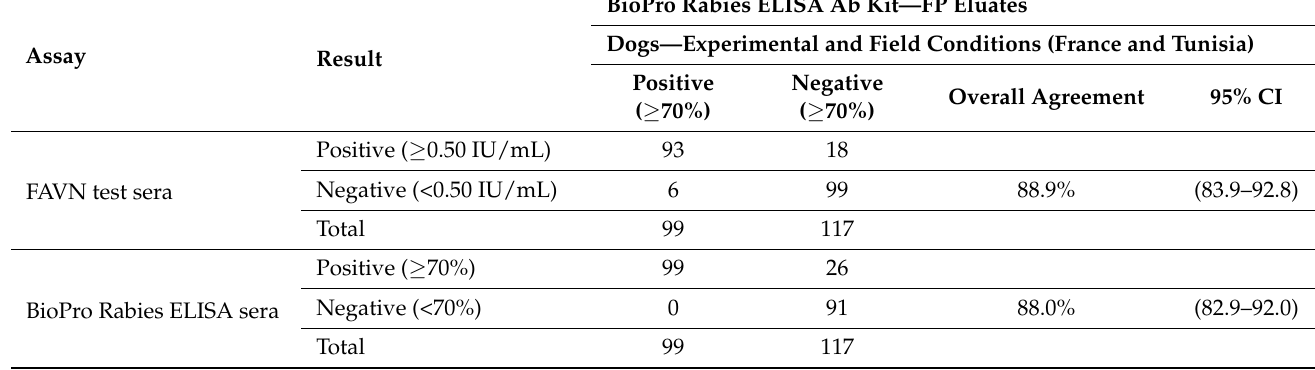
Table 3. Overall agreement between FP eluates titrated with the BioPro ELISA kit versus sera titrated with FAVN test or with ELISA